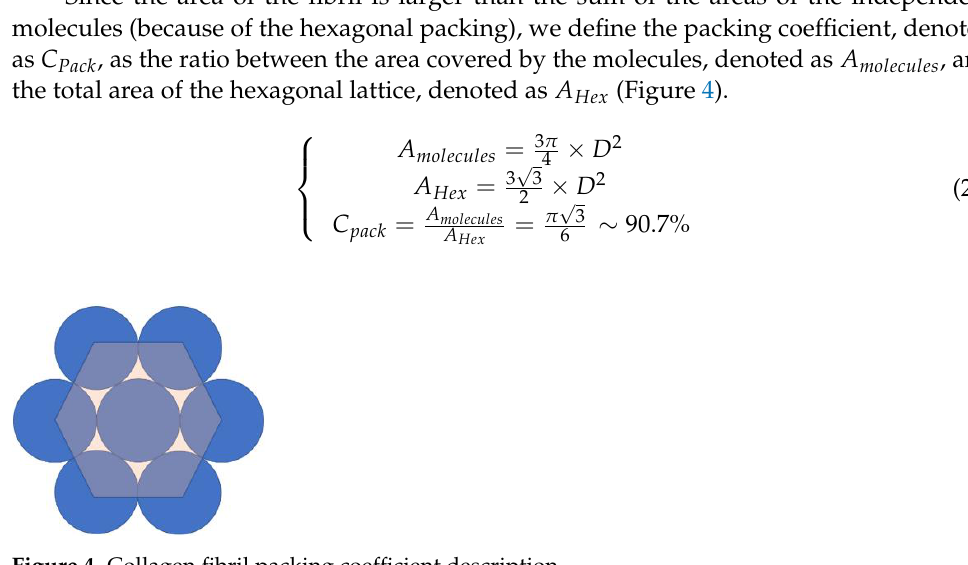
Figure 4. Collagen fibril packing coefficient description.